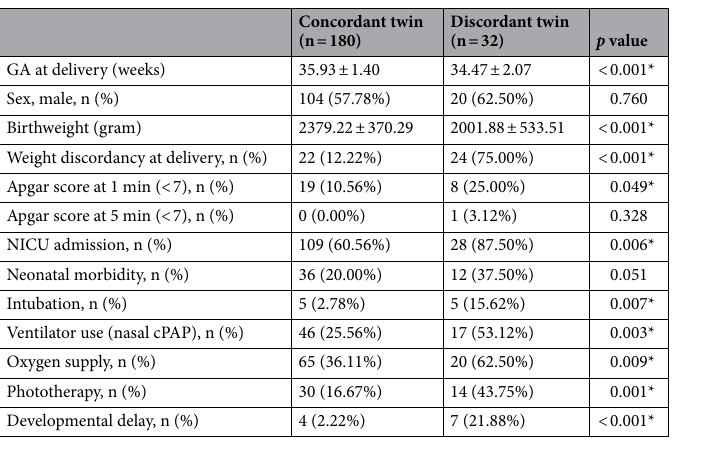
Table 4. Comparison of neonatal outcomes between the concordant and discordant twins at 28–32 weeks of gestation in DCDA twins. DCDA, dichorionic diamniotic; GA, gestational age; NICU, neonatal intensive care unit; cPAP, continuous positive airway pressure. * p values of < 0.05 are shown in bold with an asterisk (*).